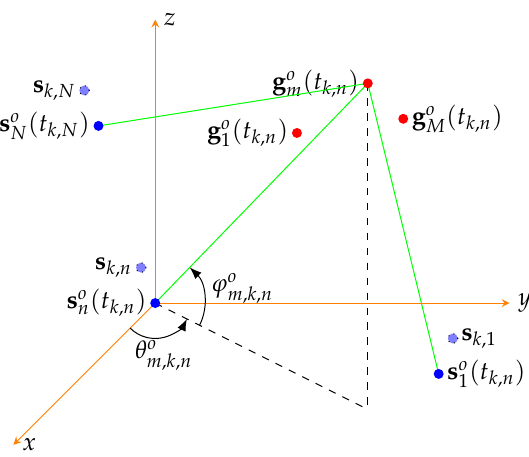
Figure 1. Measurement scenario of the passive